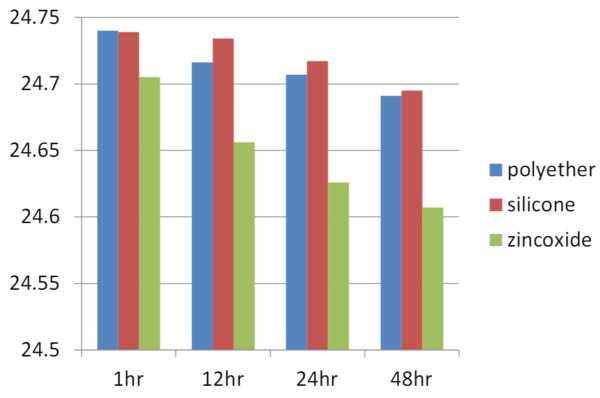
Showing the comparison ofdimensional stability of threeinterocclusal recording materials atdifferent hours using ANOVA.